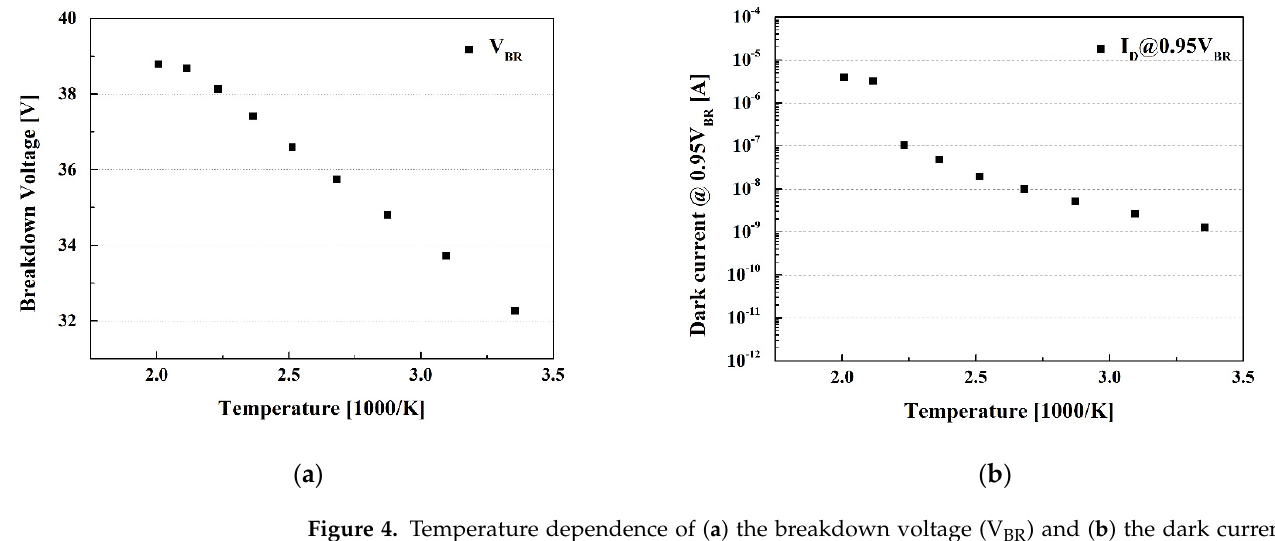
Figure 4. Temperature dependence of ( a ) the breakdown voltage (V BR ) and ( b ) the dark current (I D ) characteristics.